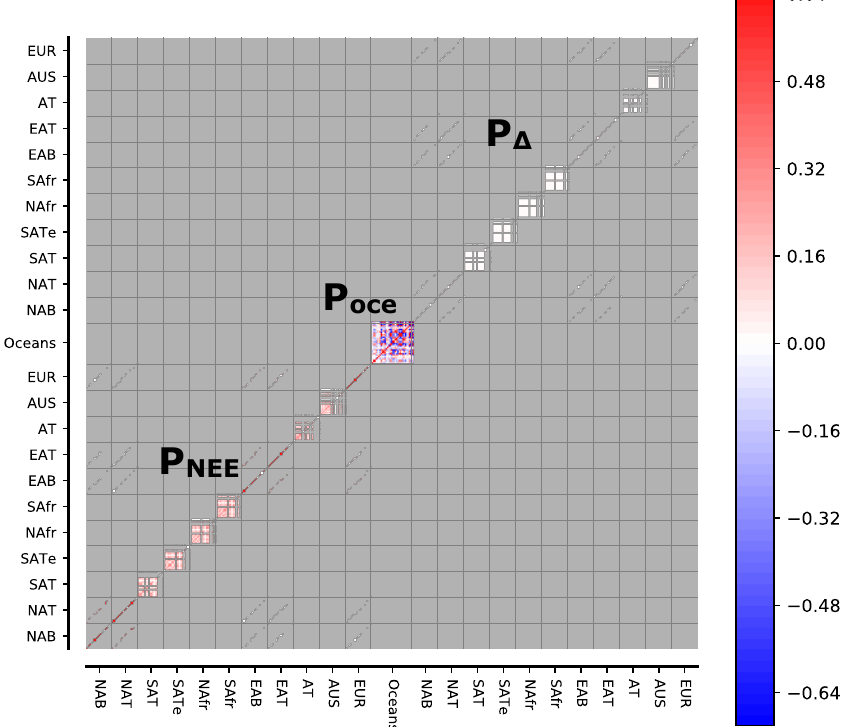
Figure 3. The prior P covariance structure represents squared uncertainty of the dimensionless state vector. The first 209 × 209 element block represents the covariance matrix for land NEE with a maximum diagonal uncertainty of 0.64 (equivalent to 80%), the second 30 × 30 element block represents the covariance matrix for ocean fluxes with a maximum diagonal uncertainty of 1.0 (equivalent to 100%), and the third 209 × 209 element block represents the covariance matrix for (cid:49) ph with a maximum diagonal uncertainty of 0.04 (equivalent to 20%). The matrix is organized according to TransCom ocean basins and land regions, where each land region contains 19 potential ecoregions (see Figs. 1 and